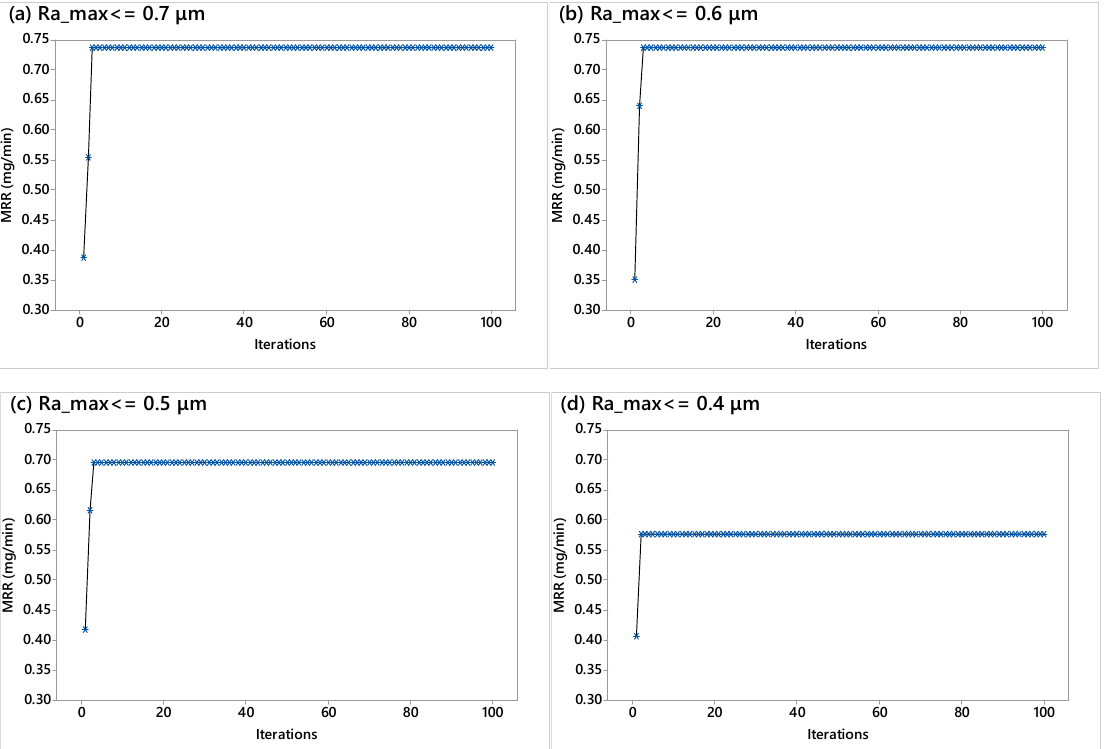
Table 4. Comparison of min Ra and max MRR among genetic algorithm (GA), multi-objective virus-evolutionary genetic algorithm (MOVEGA), and actual experimental results for the conventional abrasive flow nano-finishing process exam- ined in [2].